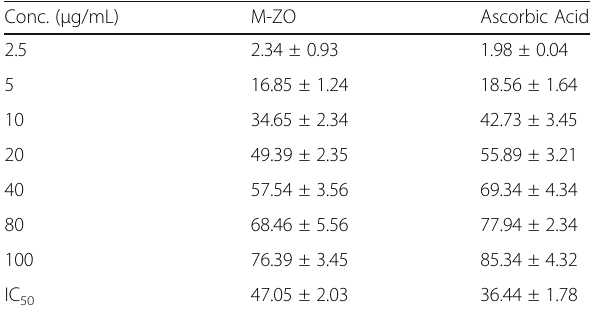
Table 3 DPPH radical scavenging activities of methanol extract of Zingiber officinale